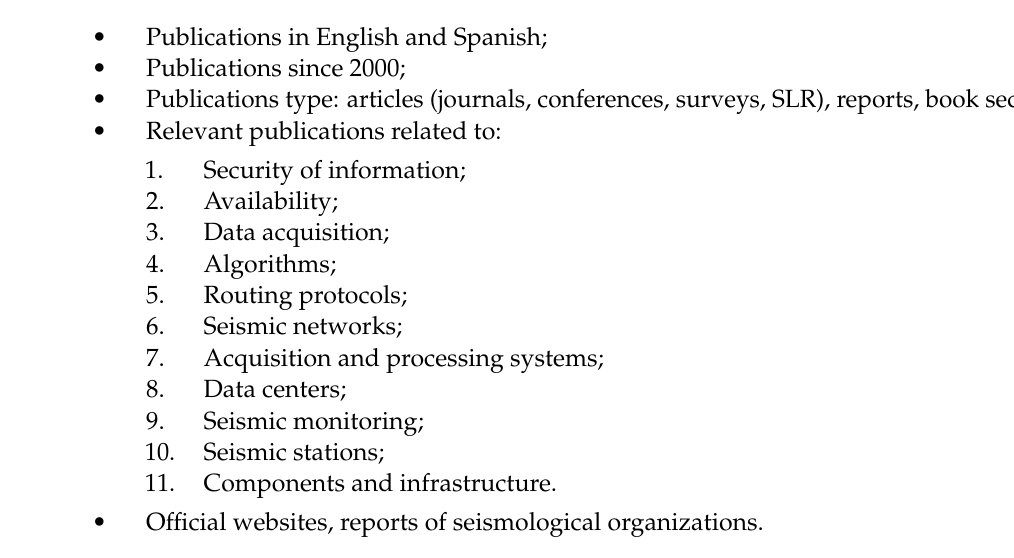
Table 1. Structuring search